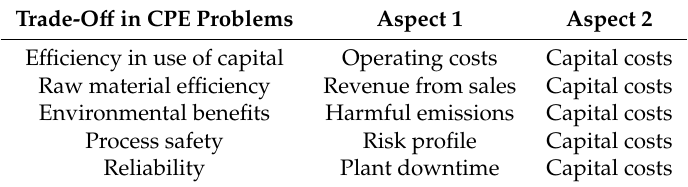
Table 1. Typical trade-o ff s in process optimization. CPE: chemical process